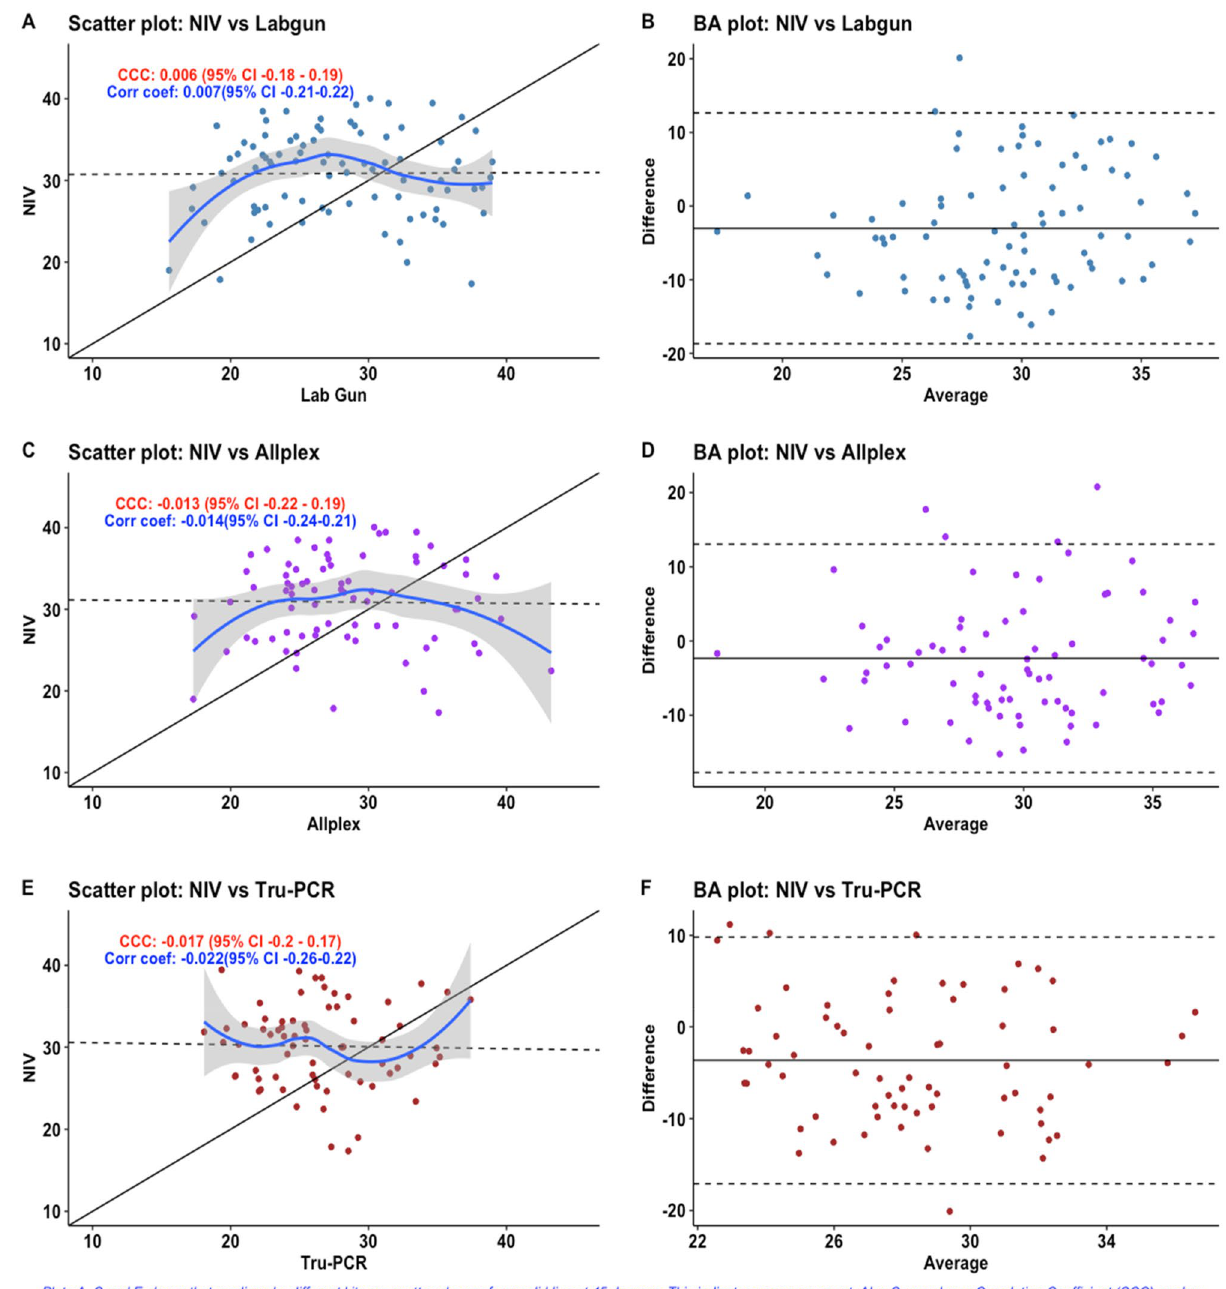
Figure 1. Scatter and Bland -Altman plots for RdRp-Ct values of different